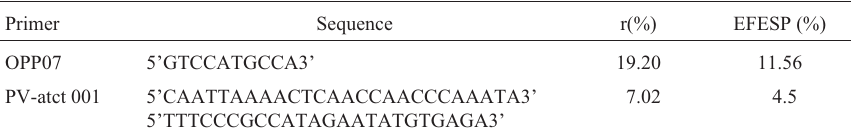
Table 4 - Expected frequency estimates of susceptible plants (EFESP) selected as resistant in the F 2 through the RAPD (OPP07) and SSR (PV-atct 001)